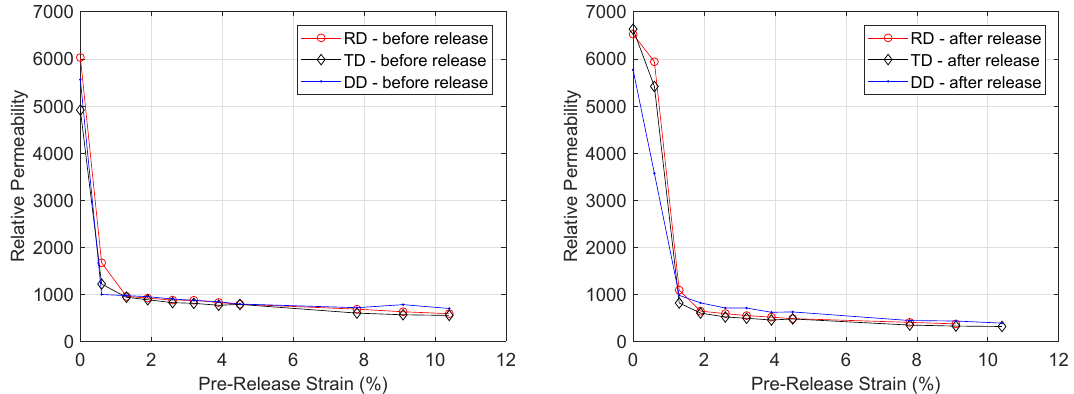
Figure 8. Evolution of relative magnetic permeability at peak magnetic flux density B p 1 T under increasing levels of strain before ( left ) and after ( right )